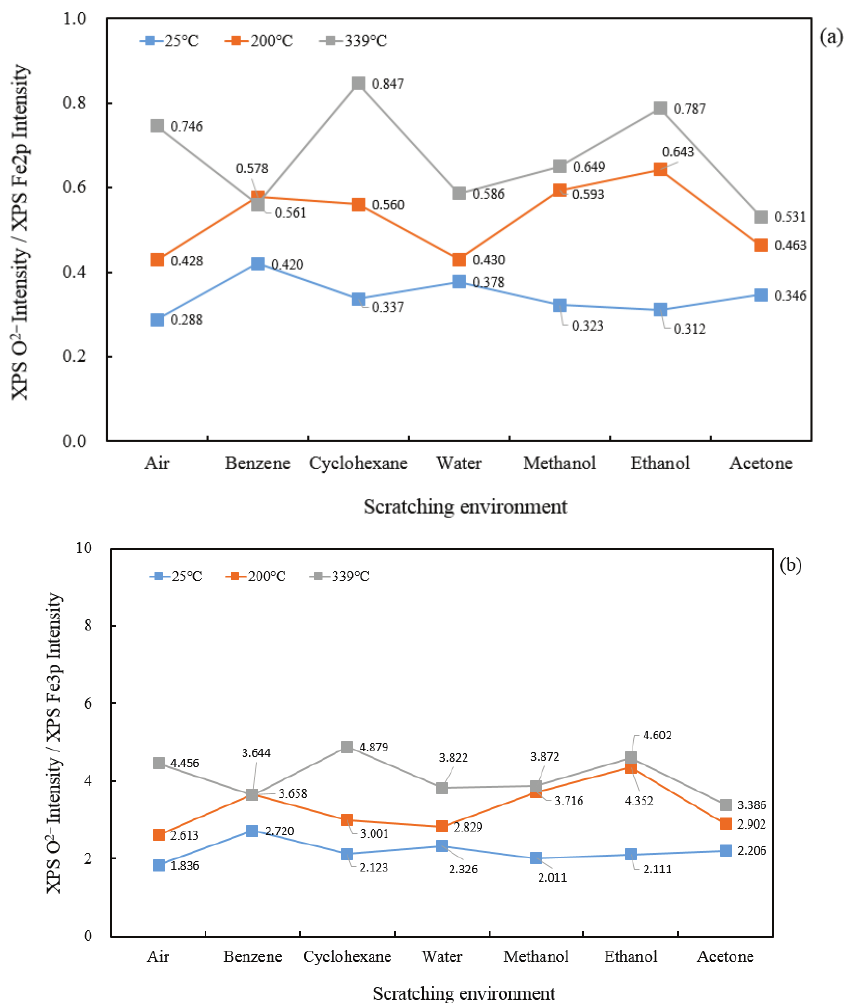
Figure 16. Dependence of ( a ) the ratio of XPS O 2 − intensity to XPS Fe 2 p intensity and ( b ) the ratio of XPS O 2 − intensity to XPS Fe 3 p intensity obtained from the O 1 s , Fe 2 p , and Fe 3 p XPS spectra for 25, 200, and 339 ◦ C for real iron surfaces on the scratching environments.